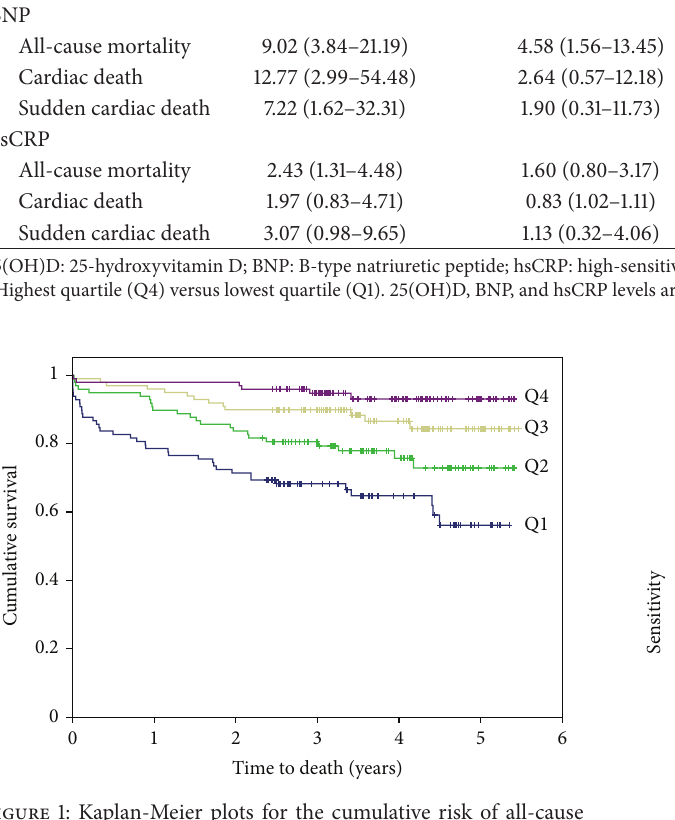
Figure 1: Kaplan-Meier plots for the cumulative risk of all-cause mortality in women in the 25(OH)D quartiles.